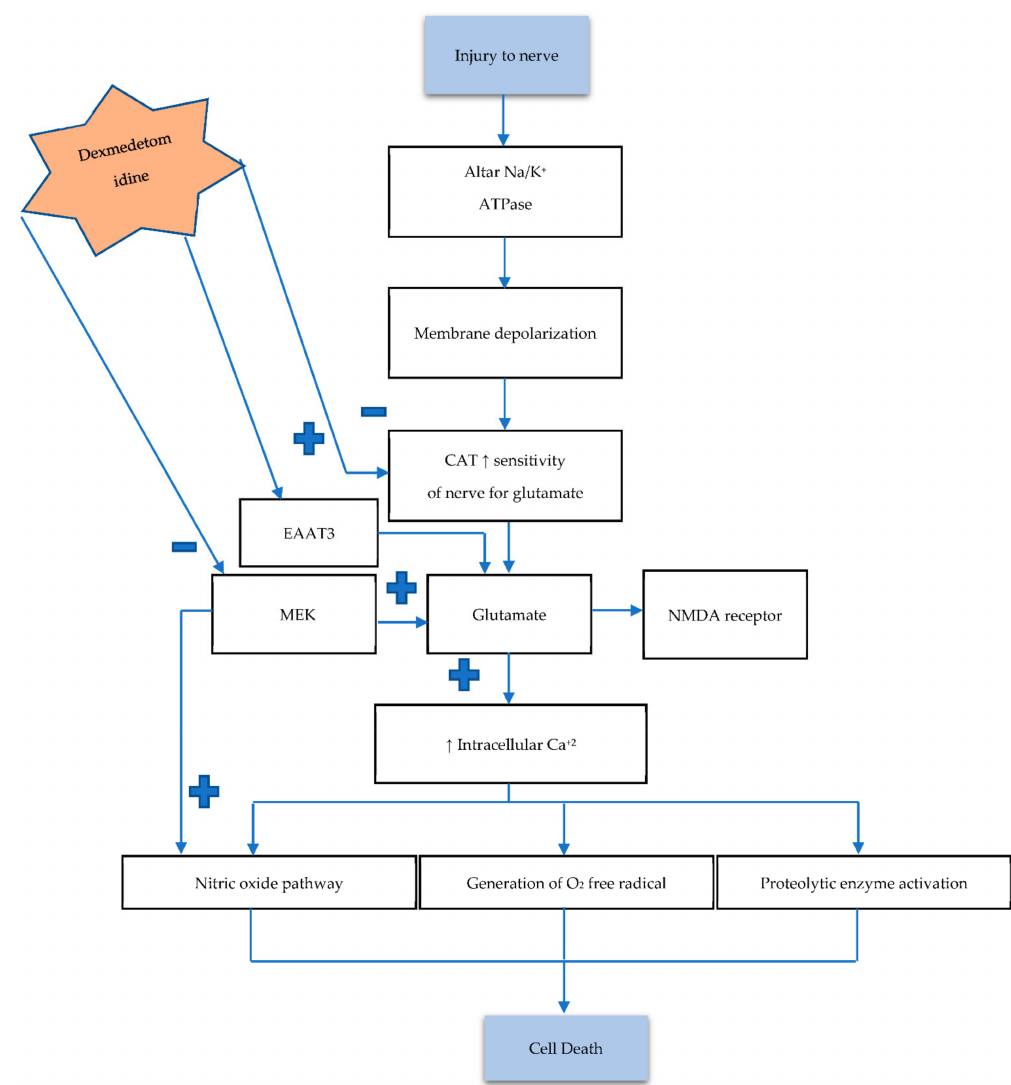
Figure 2. Nerve injury causes dysfunction of NA/K ATPase, leading to an imbalance between neurotransmitters. Increasing CAT level enhances the sensitivity of nerves to glutamate (Glu). Excessive Glu increases intracellular Ca 2+ , which in return activates the aforementioned pathways, resulting in cell death. Activation of the mitogen-activated/extracellular signal- regulated kinase (MAK) pathway also increases Glu concentration. The α 2 adrenoreceptor exerts its possible neuroprotective mechanism by hyperpolarization, which blocks the Ca 2+ entry into presynase. Low Ca 2+ diminishes neurotransmitter release (CAT) and Glu and also decreases nerve sensitivity for Glu. DEXM also enhances Excitatory amino acid transporter 3 (EAAT3) activity, which removes Glu from the synaptic cleft. Hyperpolarization also reduces NMDA receptors, which also decreases firing and reduces intracellular Ca 2+ . DEXM also blocks MEK, resulting in decreased excitotoxic neuronal